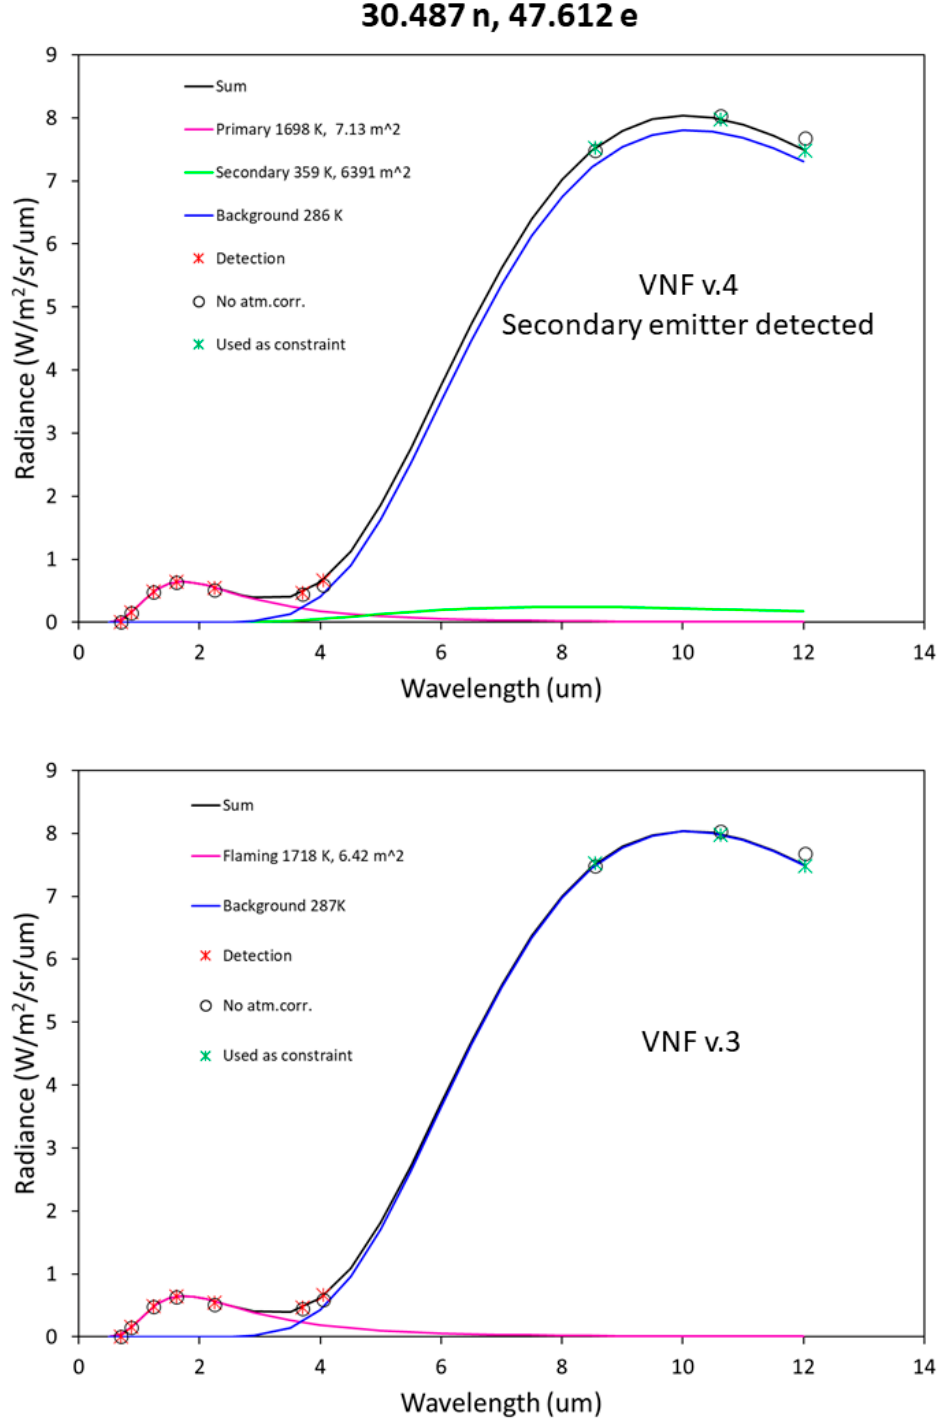
Figure 12. Spectral diagrams of a Type 4 pixel from a Basra gas flare where a secondary emitter has been detected.